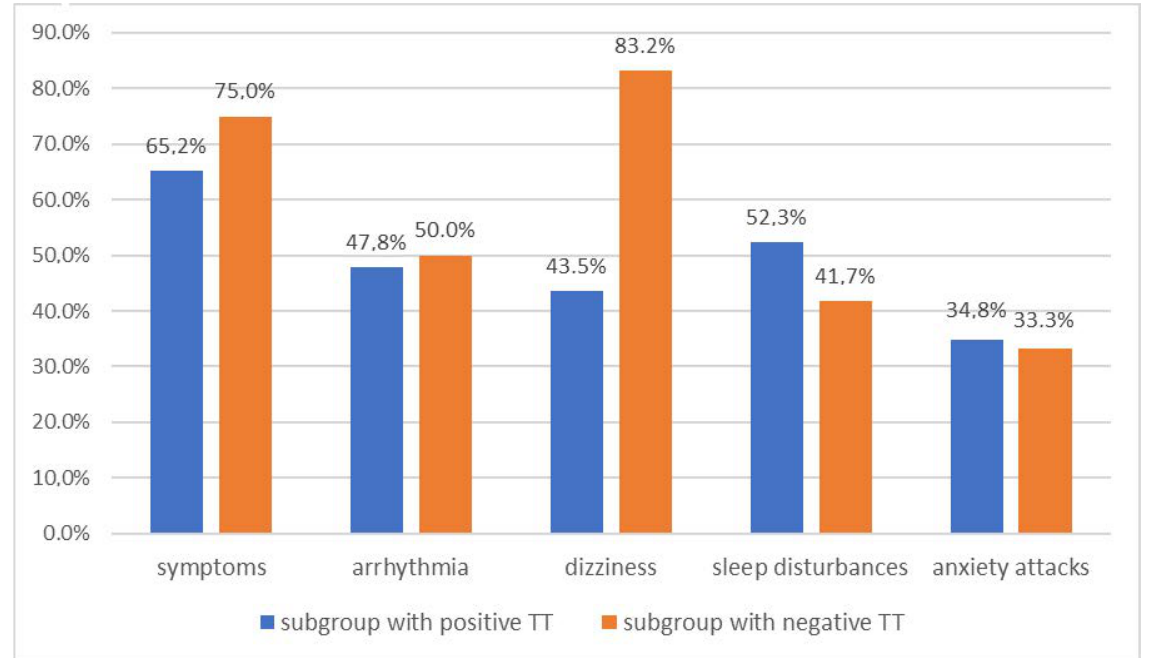
Figure 5. Comparison of the frequency of complaints and clinical symptoms between subgroups of migraine group with positive and negative tetany test results. There is no statistically significant differences between subgroup ( p > 0.05), except dizziness ( p < 0.05) which, however, is no clinically